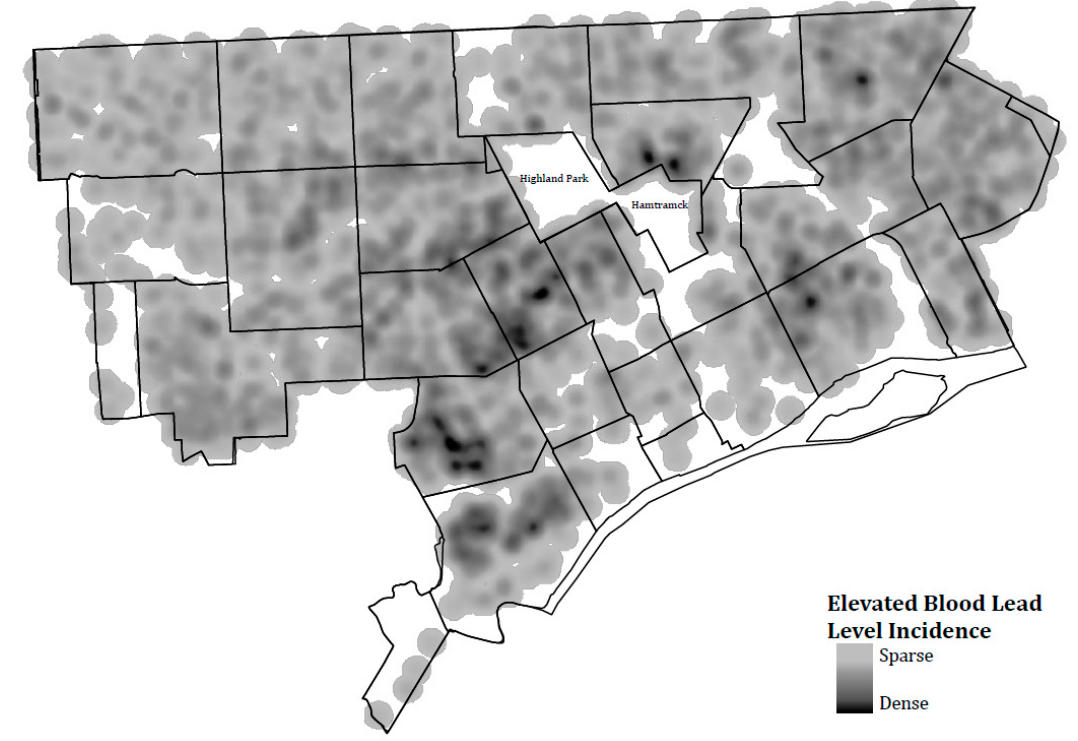
Figure 1. Incident cases of elevated blood lead levels among children under 6, Detroit, 2014–2018. Note: Heat map based on kernel density method, which calculates the density of point features around each output raster cell, with a feature count radius of 10. Elevated blood lead level incidence includes both Data